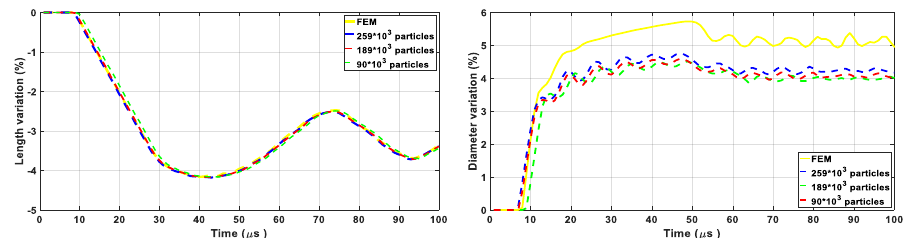
Fig. 4. Numerical variation in length (left) and diameter (right) obtained from FEM and TLSPH simulations at impact velocity of 73 m/s.